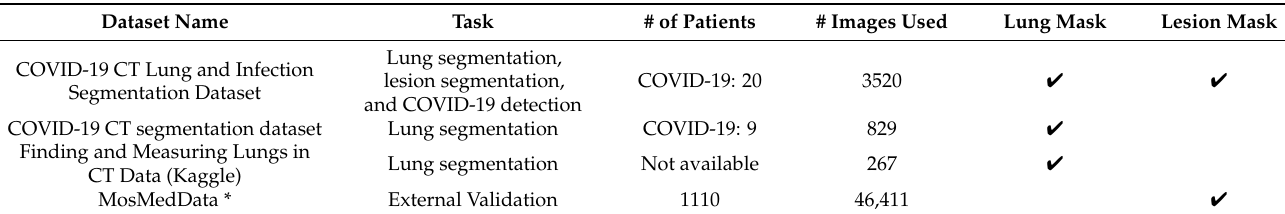
Figure 1. Schematic representation of the pipeline of the proposed COVID-19 recognition system. Table 2. Summary of datasets used in this